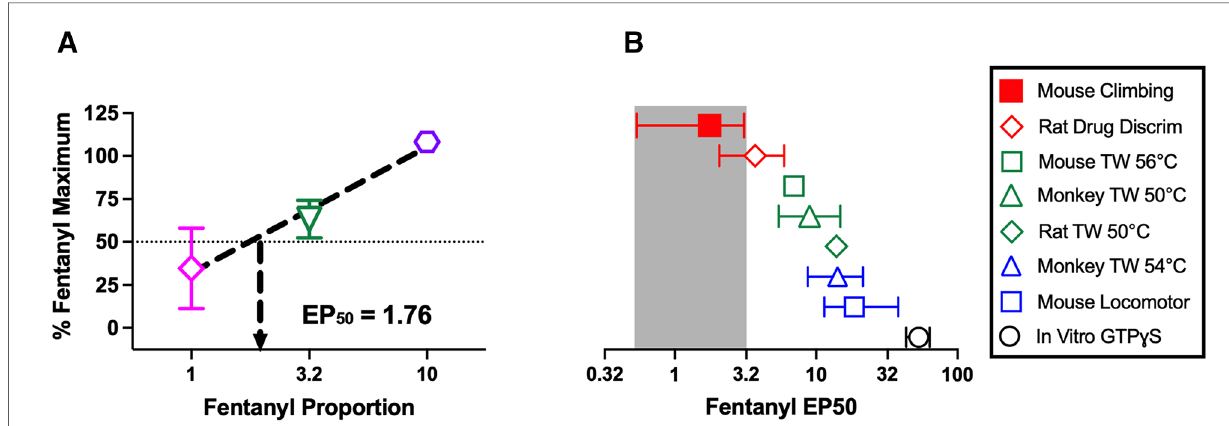
FIGURE 5 Ef fi cacy requirement for fentanyl/naltrexone mixtures to decrease climbing. ( A ) Determination of EP50 value as a measure of opioid ef fi cacy requirement to decrease climbing. Abscissa: Proportion of fentanyl in the mixture. Ordinate: Maximum effect of each mixture in Figure 4C expressed as a percentage of the maximum effect of fentanyl alone in Figure 4A . The ef fi cacy requirement of the mixtures to decrease climbing can be determined by linear regression and expressed as the EP50 value, de fi ned as the proportion of fentanyl suf fi cient to produce a maximum effect equal to 50% of the fentanyl-alone maximum. Points show mean±SEM of N =11 – 12 mice. ( B ) Comparison of EP50 values across multiple endpoints determined either in vivo (in the designated species) or in vitro (in cultured cells expressing the mouse mu opioid receptor) as reported in previous publications. Error bars show 95% con fi dence limits. Drug Discrim, drug discrimination; TW X°C, warm-water tail-withdrawal assay of thermal antinociception with a water temperature of X°C; GTP ɣ S, assay of agonist-stimulated [ 35 S]GTP ɣ S